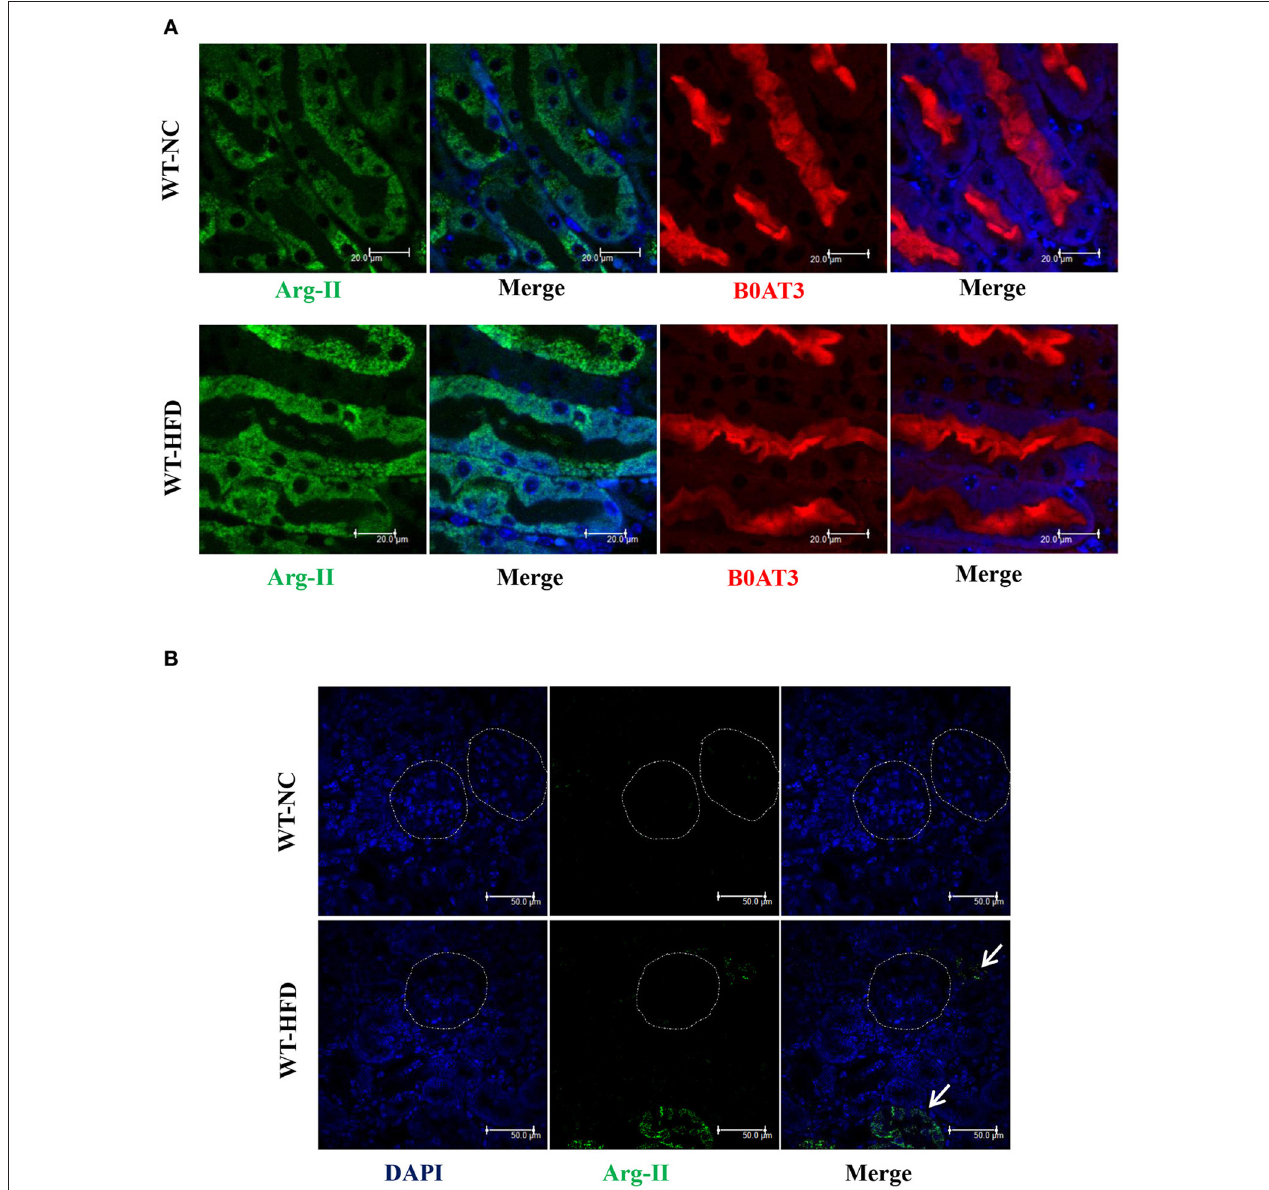
FIGURE 3 | Arg-II is localized in proximal straight tubules. (A) Confocal immunofluorescence staining in consecutive sections demonstrates that Arg-II (green) is localized in the S3 proximal straight tubules which are positive for B0AT3 (Slc6a18, red, a luminal marker of S3 proximal straight tubules) in WT mice fed either a normal chow (NC) or high fat diet (HFD). (B) No obvious Arg-II (green) signal was detected in glomeruli (circled area) in WT mice fed either NC or HFD. Some Arg-II signals were observed in tubules outside glomeruli (green indicated by arrows). Representative images of individual staining and merged images are shown ( n = 4).